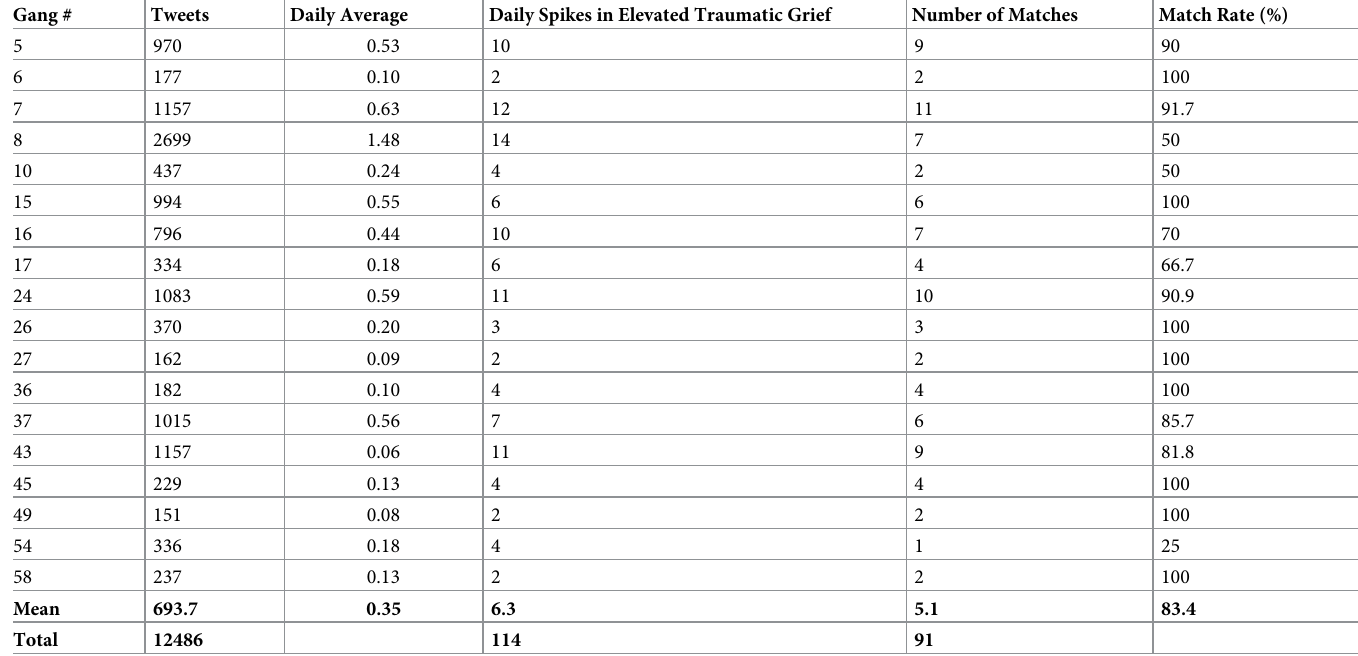
Table 1. Elevated collective traumatic grief by gang